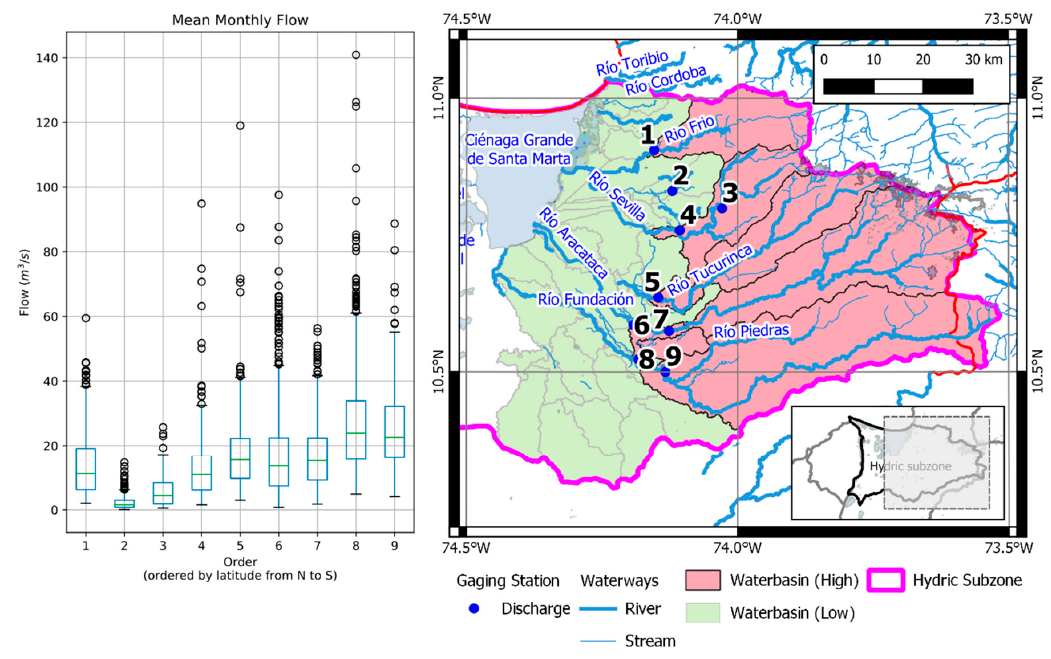
Figure 3. Hydrological stations and discharges in CGSM from north to south. The box plot shows the differences between upstream and downstream discharges. Irrigated crops are found downstream (north).